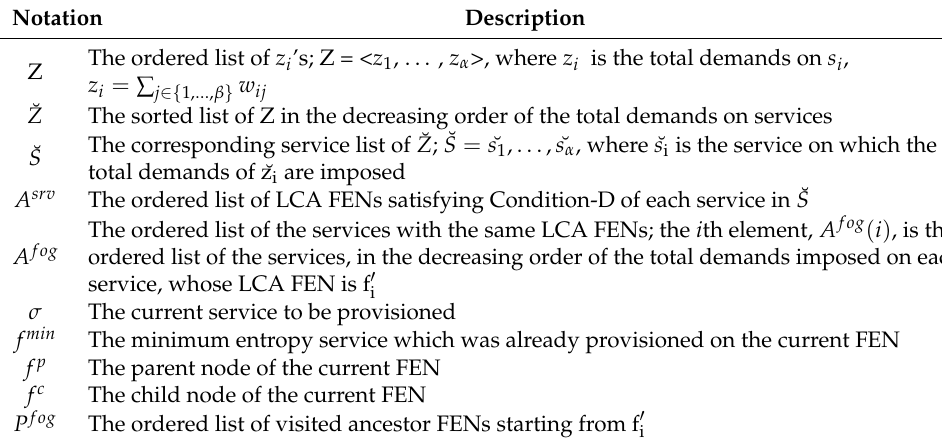
Table 3. Additional notations for the flexible coverage-SP (FC-SP)